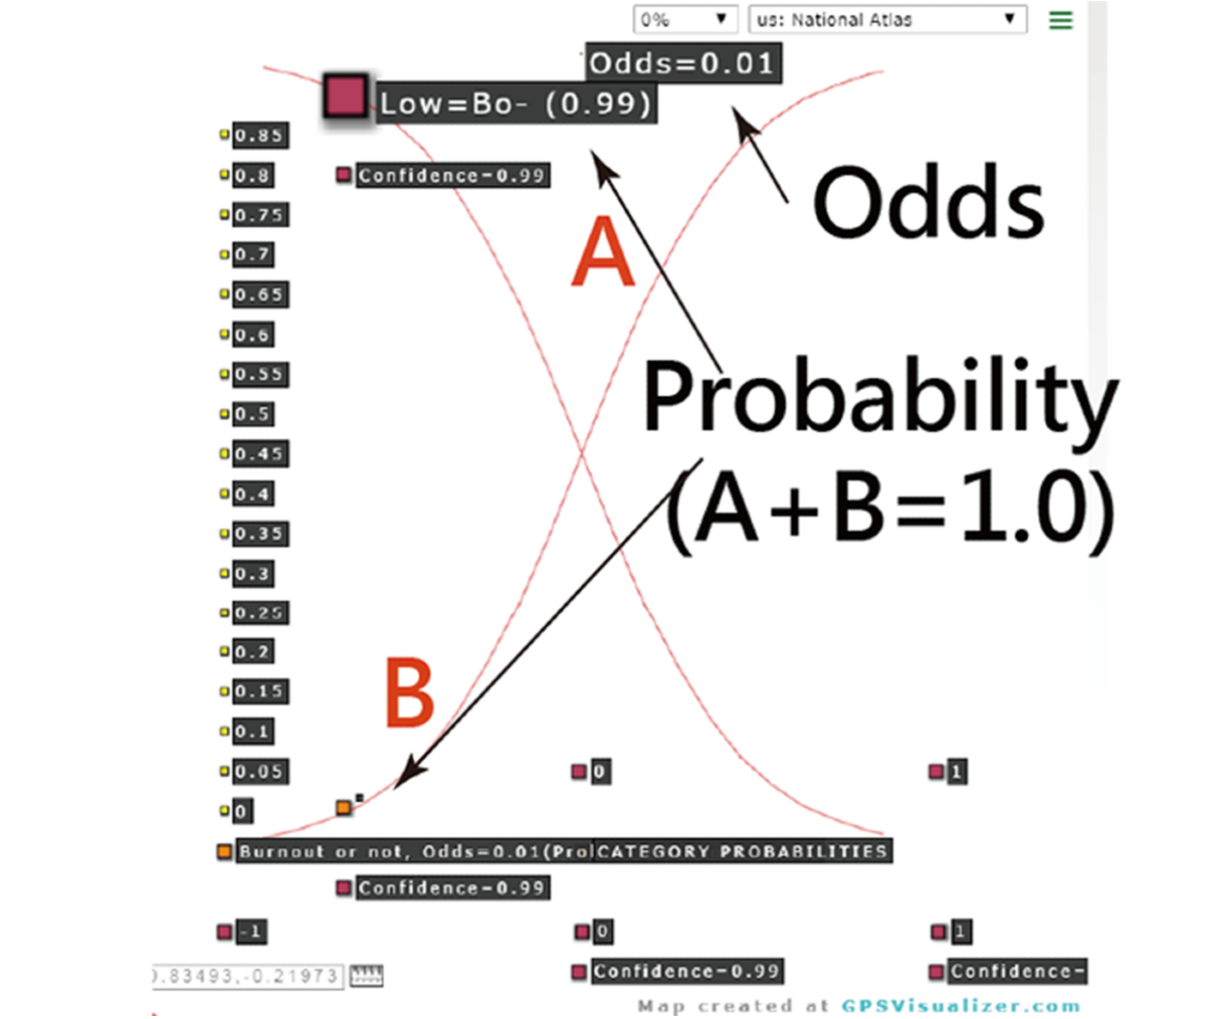
Figure 5. The result of assessing nurse